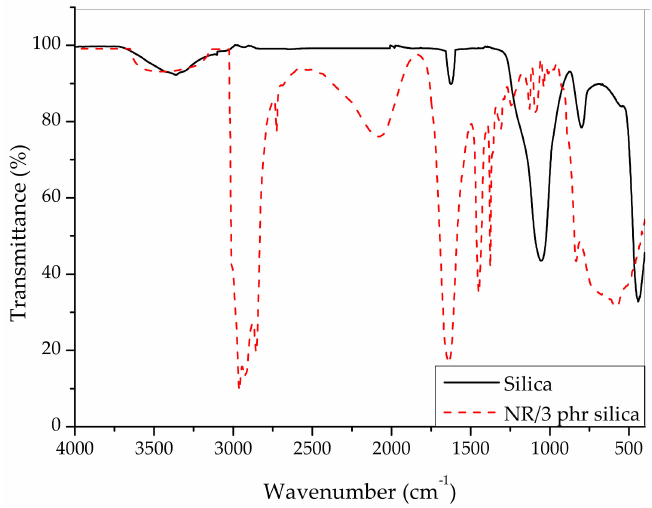
Figure 2. FT-IR spectra of fabricated nanosilica and natural rubber (NR) / 3 phr silica composite.